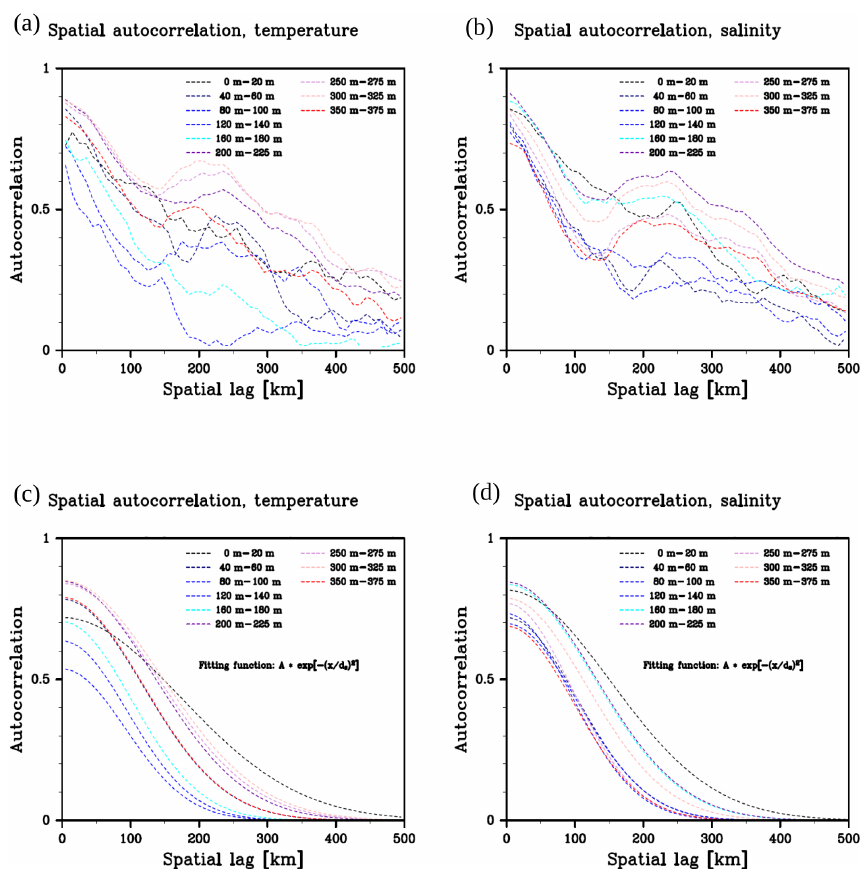
Figure 10. Spatial autocorrelation function of temperature (a, c) and salinity (b, d) . The upper panels show the temporal averages of the two- dimensional autocorrelation functions (the average of the 0- to 30-day lag for the 0–140m depth range, 0- to 60-day lag for the 140–400m depth range) in various depth levels. The lower panels are Gaussian functions, the intercepts and e -folding scales of which are calculated from the function fitting in the 0–150km spatial-lag